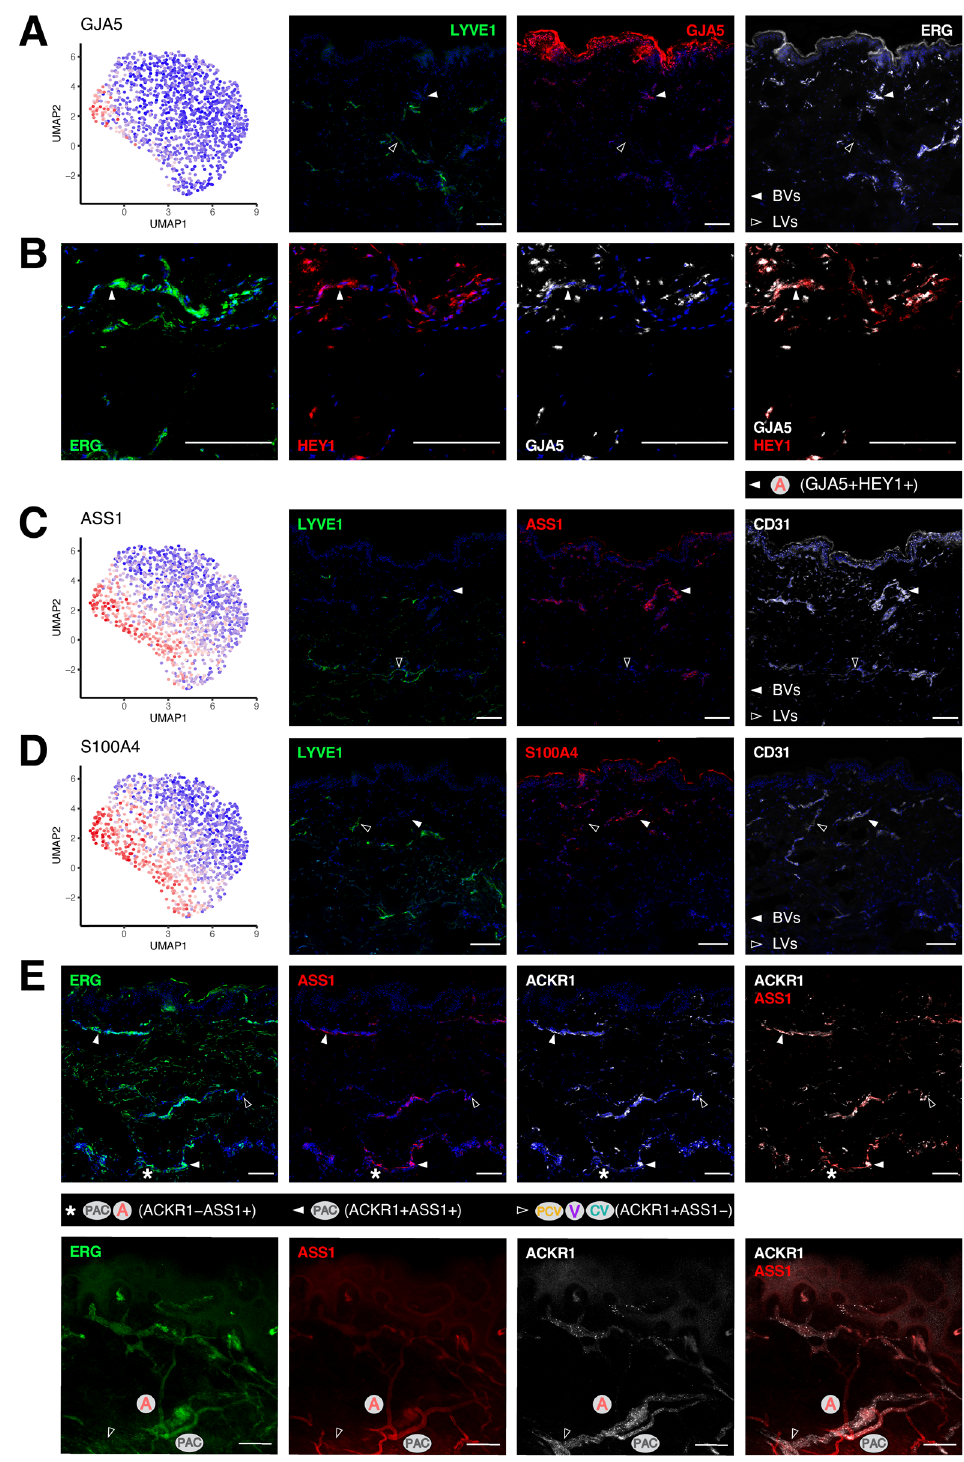
Figure 4 . Molecular characterization of arteriole and post-arterial capillary endothelial cells. Exclusive expression of the arterial marker GJA5 by BVs (white arrowheads ( A )) and its overlay with HEY1 ( B ). The expression of ASS1 ( C ) and S100A4 ( D ) was restricted to the A and PAC clusters (white arrowheads). ( E ) Differential localization of ACKR1 and ASS1 discerns arterioles and post-arterial capillaries. Representative confocal images of section (upper) and whole-mount staining (lower) of ERG (green), ASS1 (red) and ACKR1 (white). Scale bars: 100 µm.